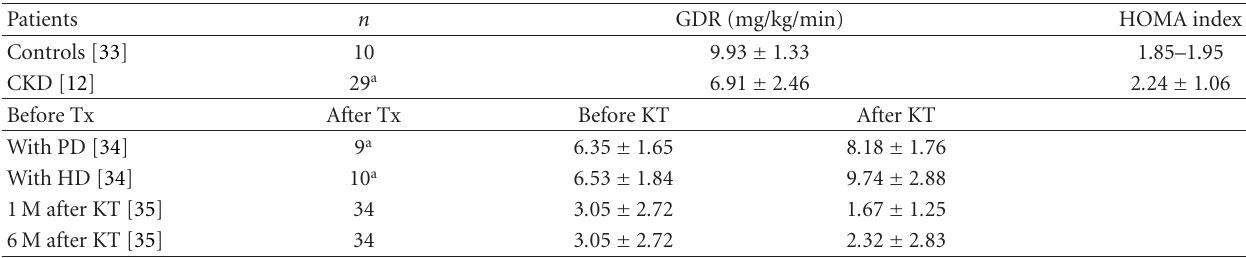
Table 1: Clinical studies assessing IR in healthy controls, CKD patients, and patients receiving PD, HD, or kidney transplantation (KT). Patients n GDR (mg/kg/min) HOMA index Controls [33]